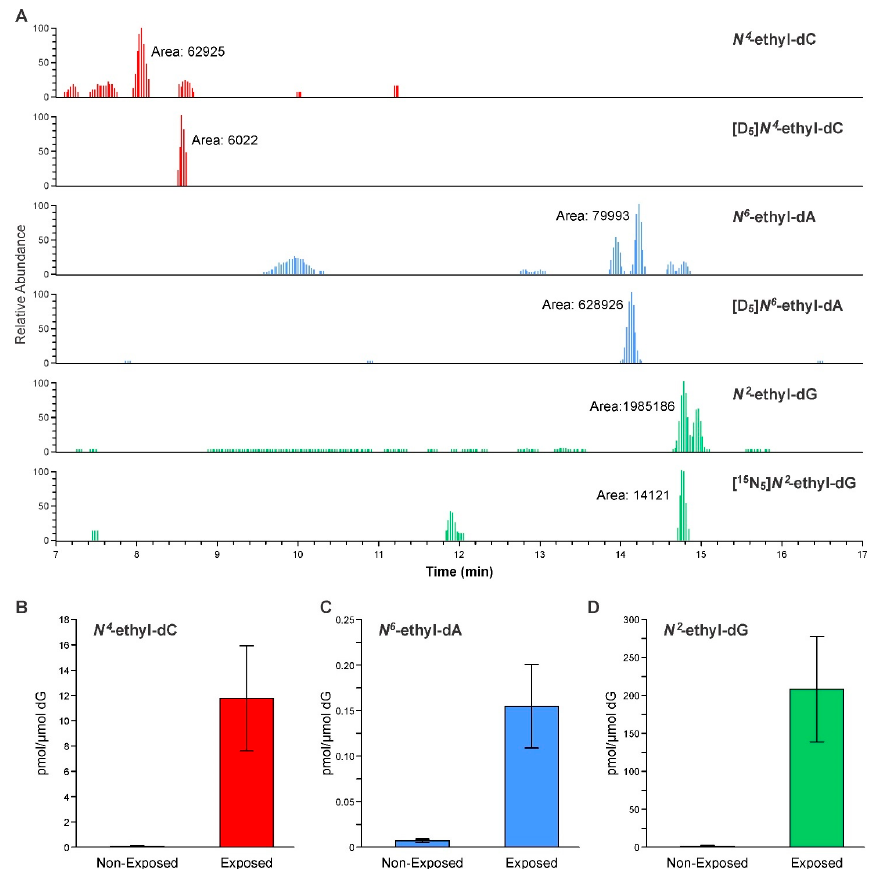
Figure 5. Panel A : NanoLC ‐ HRMS 2 chromatograms of ethyl ‐ adducts in human oral ‐ cell DNA isolated Figure 5. Panel ( A ): NanoLC-HRMS 2 chromatograms of ethyl-adducts in human oral-cell DNA isolated from alcohol- from alcohol ‐ exposed volunteers. Amounts of N 4 ‐ ethyl ‐ dC (panel B ) volunteers, N 6 ‐ ethyl ‐ dA (panel exposed volunteers. Amounts of N 4 -ethyl-dC (panel ( B )) volunteers, N 6 -ethyl-dA (panel ( C )) volunteers, and N 2 -ethyl-dG (panel ( D )) (pmol/ µ mol dG) in human oral-cell DNA of nonexposed and alcohol-exposed